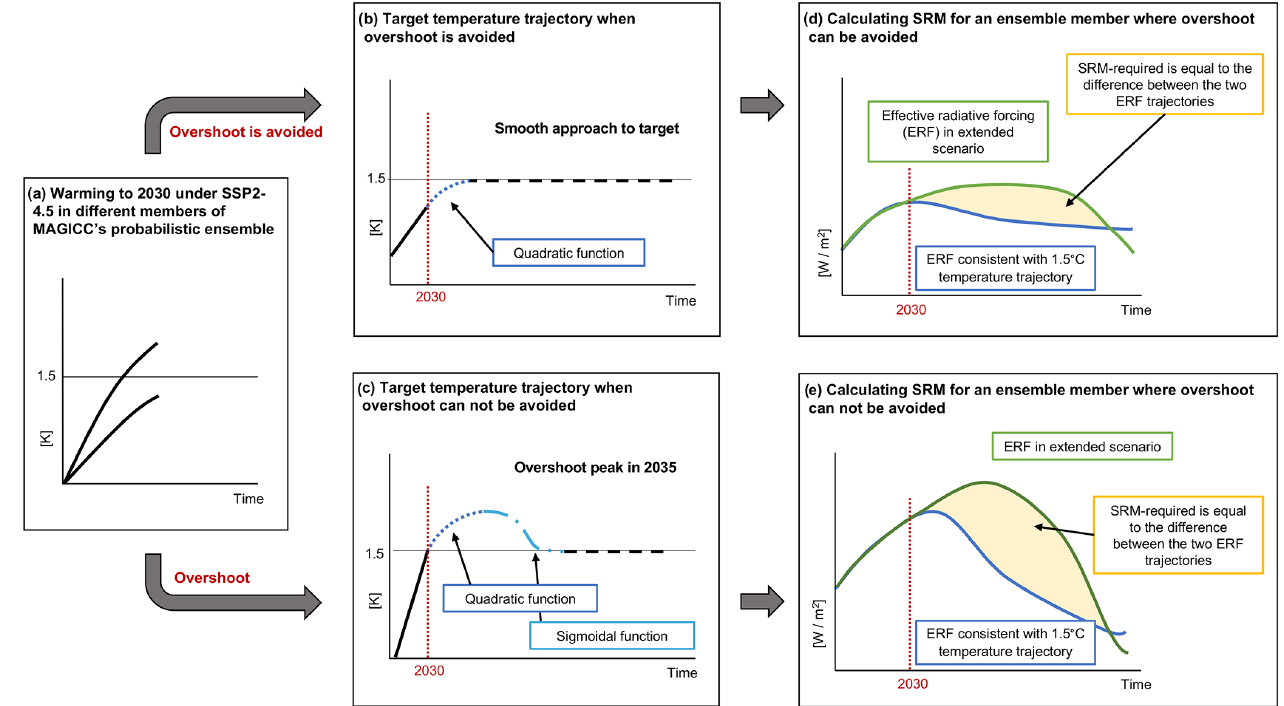
Figure 2. Calculating required SRM. (a) Calculating warming to 2035 using an NDC-like pathway (in this case, SSP2-4.5). (b) Determining a 1.5 ◦ C temperature trajectory for ensemble members that have not already overshot 1.5 ◦ C by 2035. (c) Determining a 1.5 ◦ C temperature trajectory for ensemble members that have already overshot 1.5 ◦ C by 2035. (d, e) Calculating required solar radiation modification (SRM) for each scenario–ensemble member combination, whether it overshoots 1.5 ◦ C (e) or remains below 1.5 ◦ C at all times (d) .